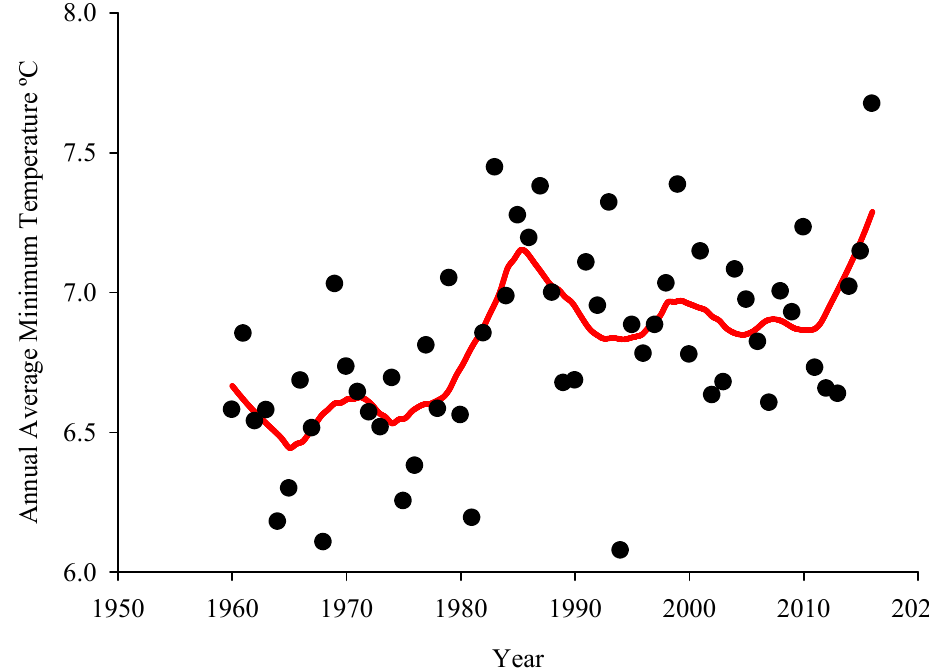
Figure 5. Lowess regression line for the annual average minimum temperature of Maloti-Drakensberg for the period 1960–2016.